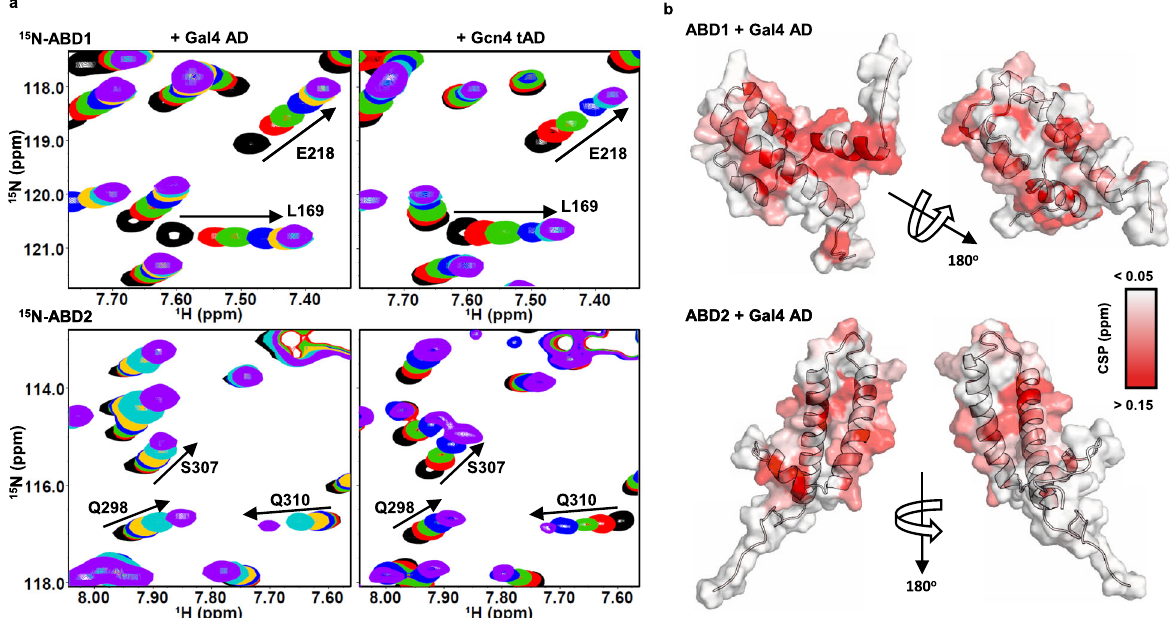
Fig. 4 Med15 ABDs have widespread CSPs upon addition of Gal4 AD that resemble the Gcn4 tAD interactions. a ( 1 H, 15 N)-HSQC titration spectra of 15 N-ABD1 (top) or 15 N-ABD2 (bottom) with Gal4 AD (left) or Gcn4 tAD (right). ABD1 and ABD2 show similar chemical shift trajectories regardless of the added activator domain. b CSPs of ABD + Gal4 AD are plotted on the structures of ABD1 (pdb 2LPB) and ABD2 (pdb 6ALY) with darker red indicating a larger CSP. See also Supplementary Fig.